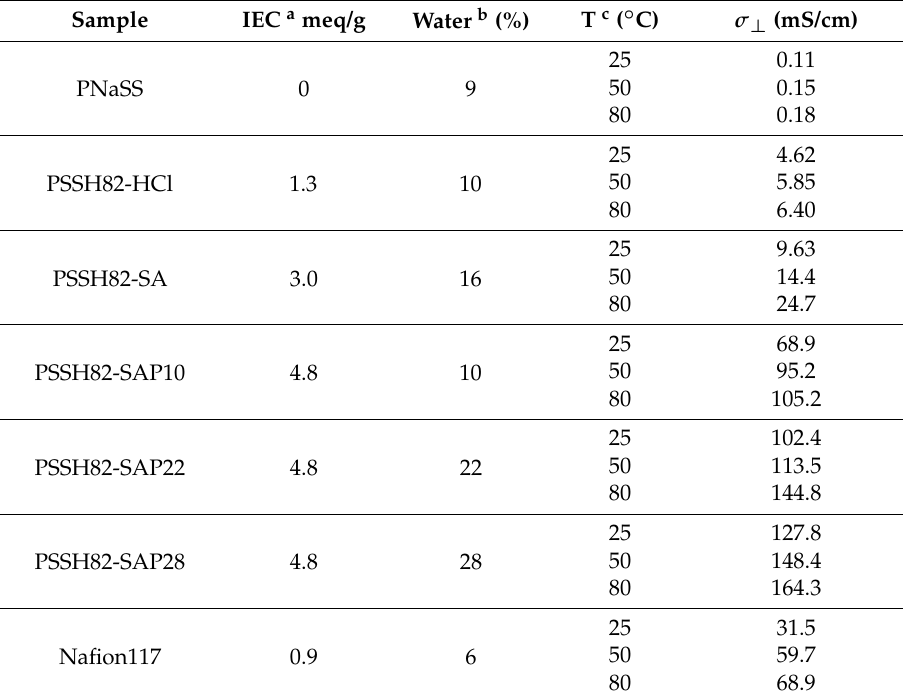
Table 2. Through-plane conductivity of the